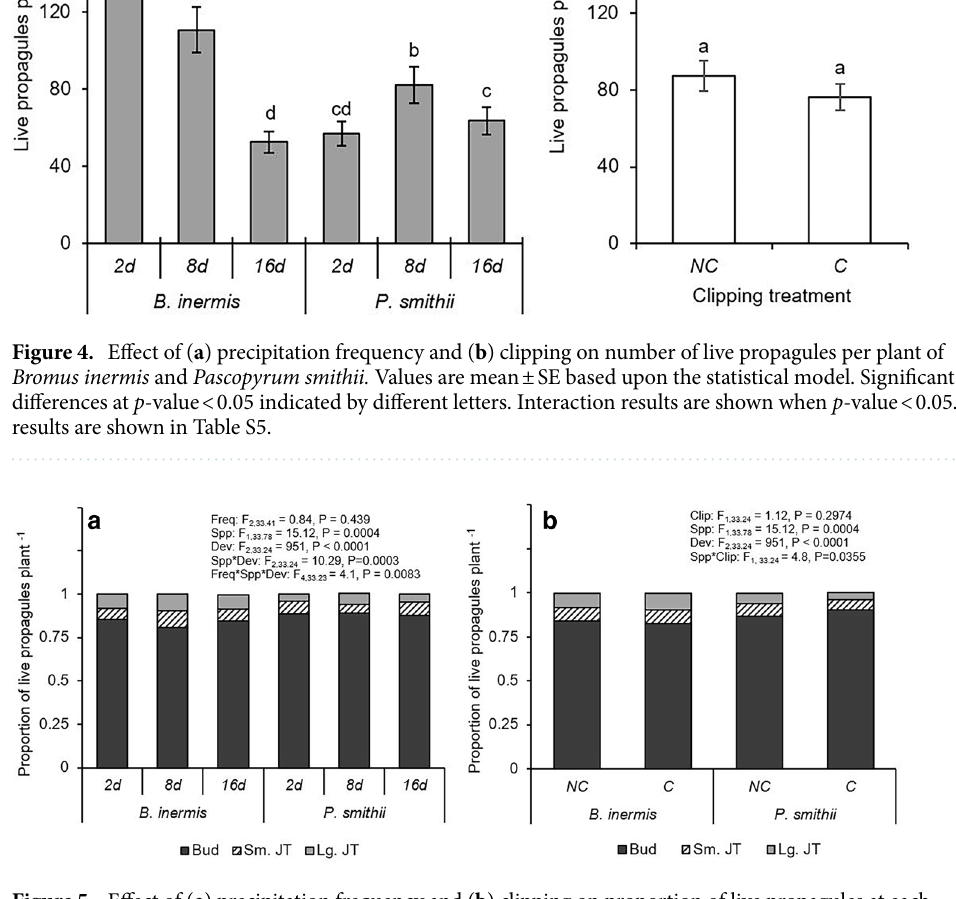
Figure 5. Effect of ( a ) precipitation frequency and ( b ) clipping on proportion of live propagules at each developmental stage per plant of Bromus inermis and Pascopyrum smithii . The proportions of live propagules were classified into three development/size classes including buds, small juvenile tillers/rhizomes (Sm. JT), and large juvenile tillers/rhizomes (Lg. JT). Interaction results are shown when p -value < 0.05. Full results are shown in Table